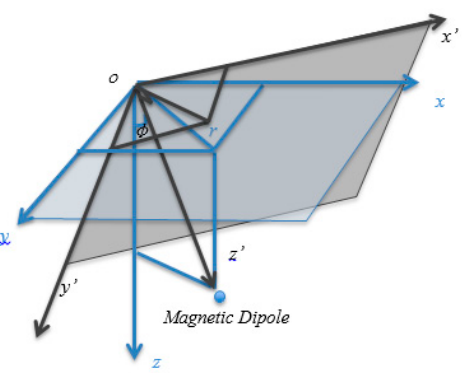
v decomposition; Angle φ is the coordination 1